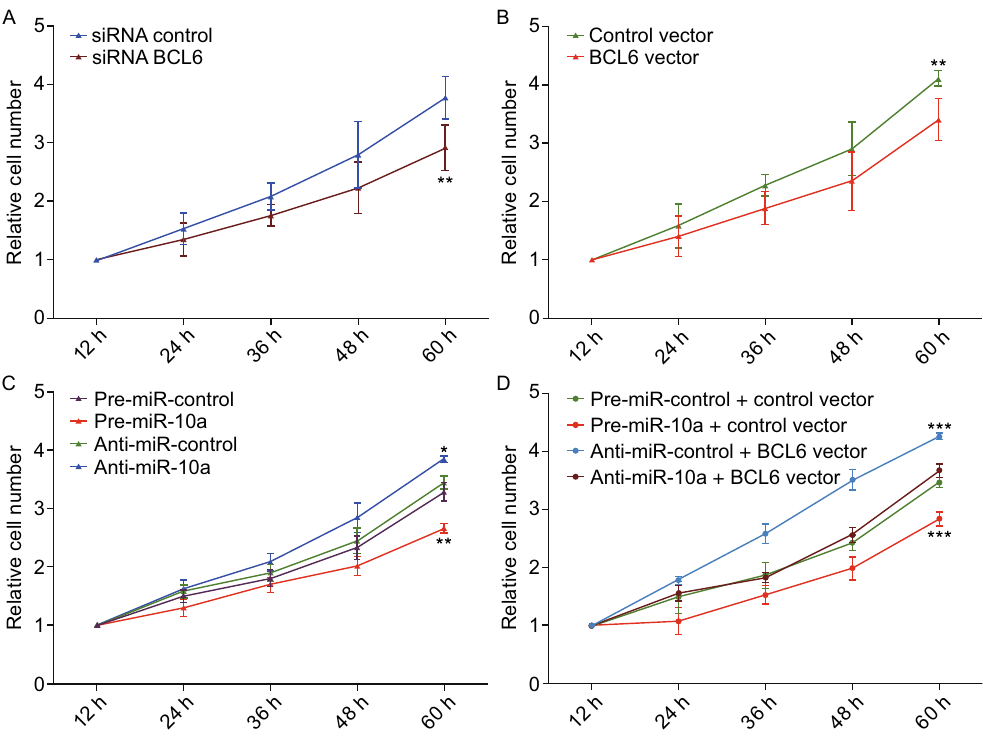
Figure 6. The role of miR-10a targeting BCL6 in the regulation of proliferation in DLBCL cells. (A) CCK8 viability assays were performed 12 h, 24 h, 36 h, 48 h and 60 h after the transfection of OCI-LY7 cells with either a control siRNA or a BCL6